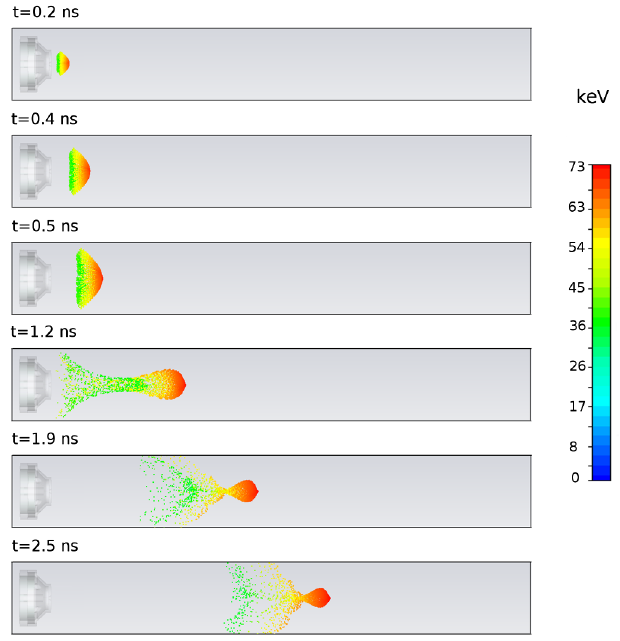
FIG. 11. Particle in cell simulation for electron beam propa- gation across the beam line shown in Fig. 1. Because of space- charge forces the 4 nC electron beam splits into several sub- bunches of different energies towards the end of the beam line. The drift region is 610 mm